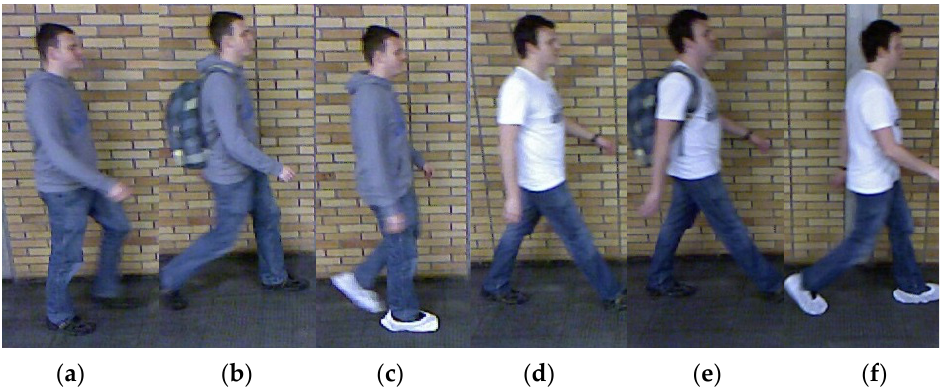
Figure 2. Scenarios in the TUM-GAID Gait Dataset [1]. ( a ) people is with seasonal clothing; ( b ) people is with seasonal clothing and backpack; ( c ) people is with seasonal clothing and shoe covers; ( d ) people is with normal clothing; ( e ) people is with normal clothing and backpack; ( f ) people is with normal clothing and shoe covers.